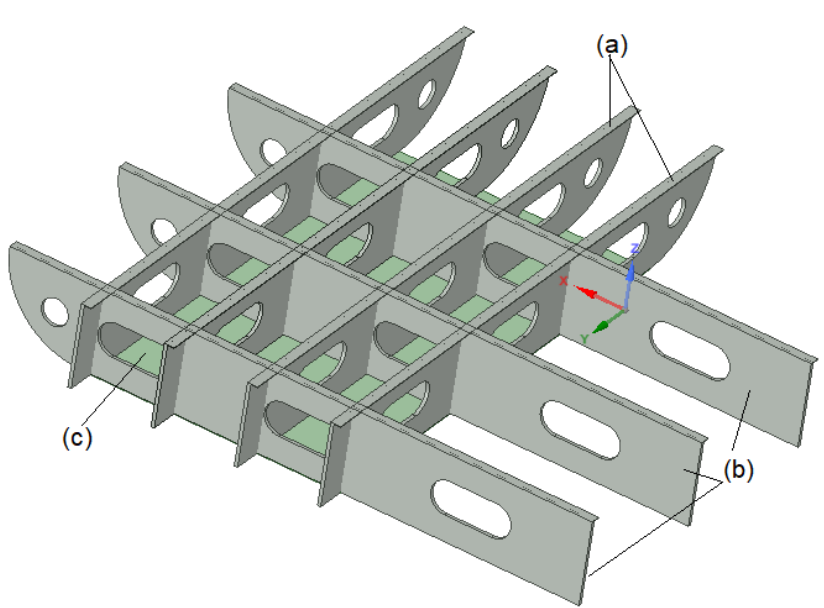
Figure 1. Plate floor details used in shipbuilding industry: (a) Flanges, (b) Traverse plate floor, (c) Cardboard strake.